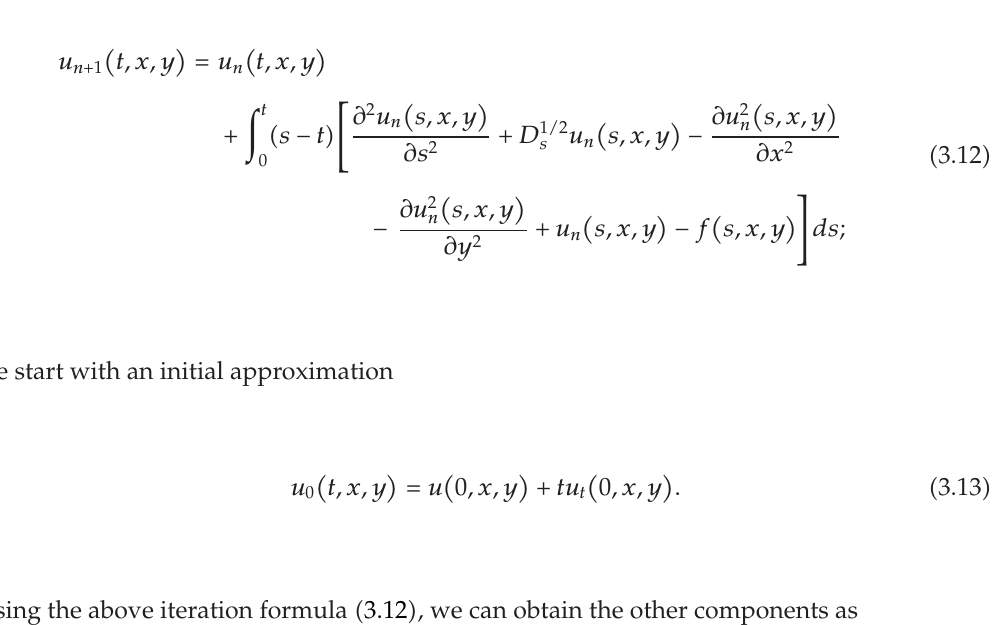
According to formula (cid:3) 3.6 (cid:4) , the iteration formula for (cid:3) 3.11 (cid:4) is given